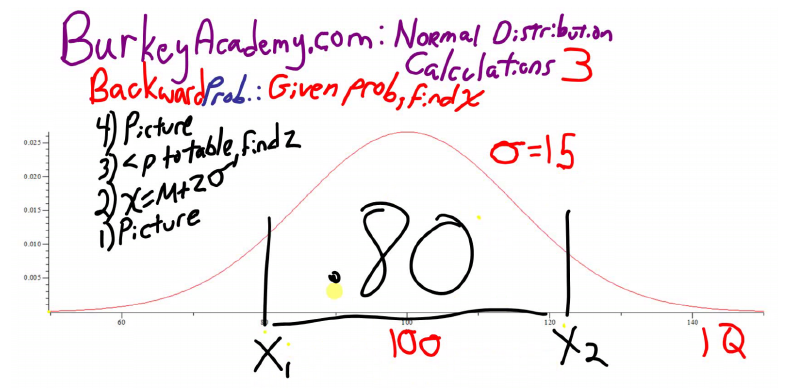
Figure 3: Using Windows Journal with Stylus to Discuss the Normal Distribution